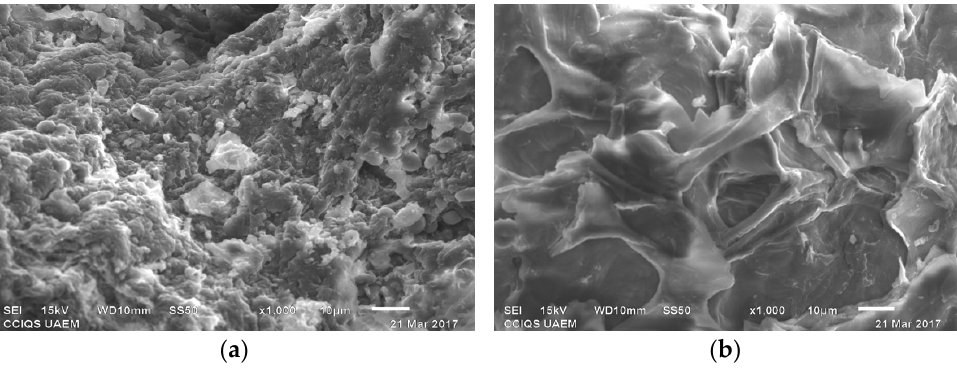
Figure 1. SEM photograph of cocoa bean shell powder at 1000× before ( a ) and after ( b ) the adsorp- tion